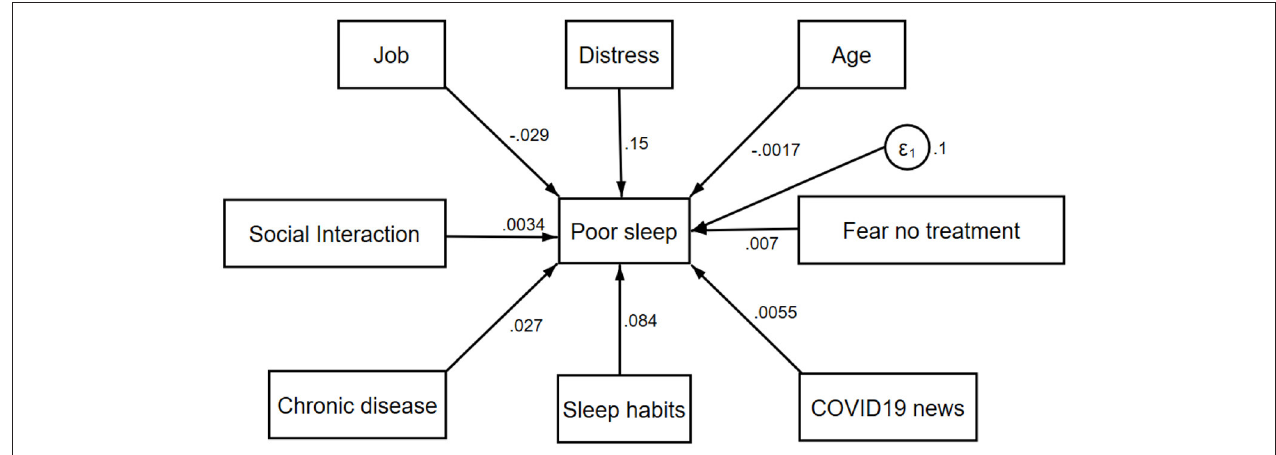
FIGURE 4 | Relationship between poor sleep and factors associated with it (Numbers on arrows indicate the effect magnitude of each variable on sleep, ε is the calculated error).